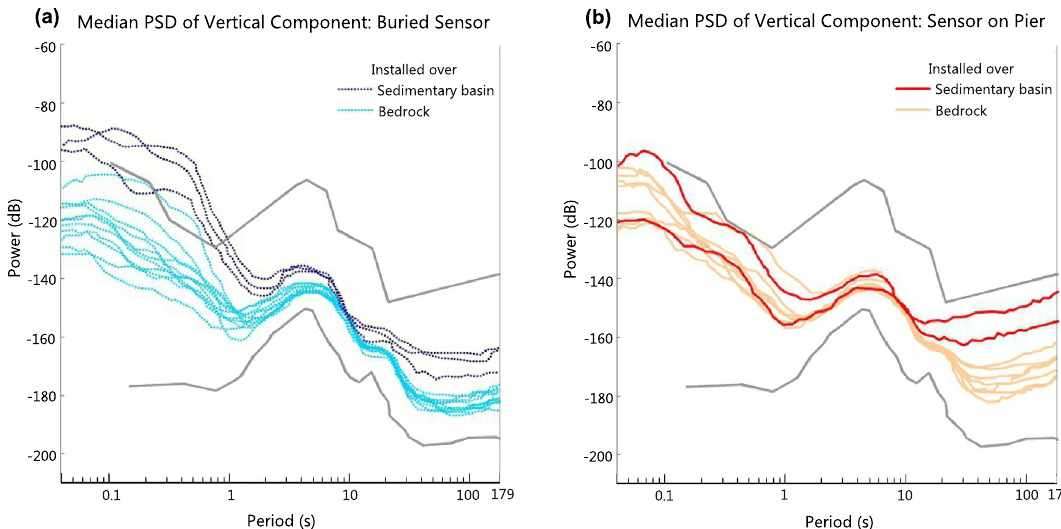
Figure 5. Median Power Spectral Density (PSD) plots to compare noise levels recorded at the sensors based on the surface on which they were installed. ( a ) Median PSDs observed at the vertical component of sensors buried underground. Deep and light blue dotted lines represent median PSDs obtained using data recorded at stations located over sedimentary basin and bedrock respectively. ( b ) Median PSDs observed at the vertical component of sensors installed on a pier. Red and pink solid lines represent median PSDs obtained using data recorded at stations located over sedimentary basin and bedrock Geographic variation. As we move from the Himalayan foreland basin in the south to the Sikkim Hima- layas in the north, the geography and population density changes gradually. The geography changes from low- lying plains in the south to high altitude mountains in the north. 2011 census data of India (Source: https:// www. censu s2011. co. in/) reveals that the Himalayan foreland basin areas of northern West Bengal are densely populated (622 persons per sq.km). The Darjeeling Himalayas has 586 persons per sq.km, compared to the meager 117 and 10 persons per sq.km in south and north Sikkim, respectively (Fig. 6a). Overall, the population density in the southern region of our study area is much higher than that in the north. We have spatially plotted